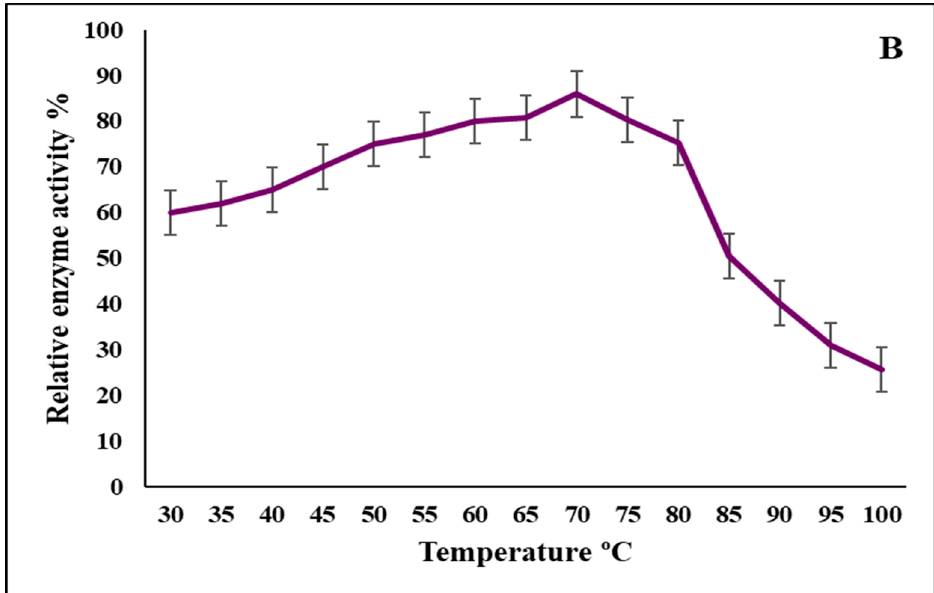
Figure 9. Effect of temperature ( A ) and thermal stability ( B ) on the activity of purified chitinase on SSF by T. funiculosus strain CBS 129594. The values are the means of three replicates with standard deviation (±SD).